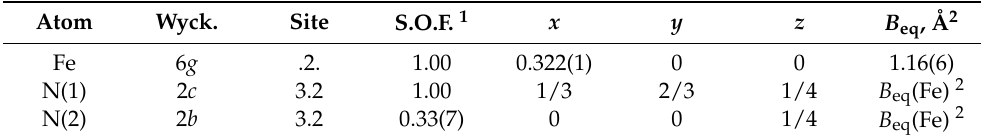
Table 7. Atomic coordinates of siderazot in ambient conditions.